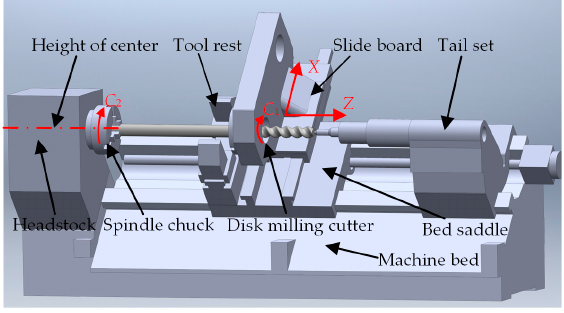
Figure 8. Whirlwind milling machine with LXK100 four-axis double-headed screw rotor.